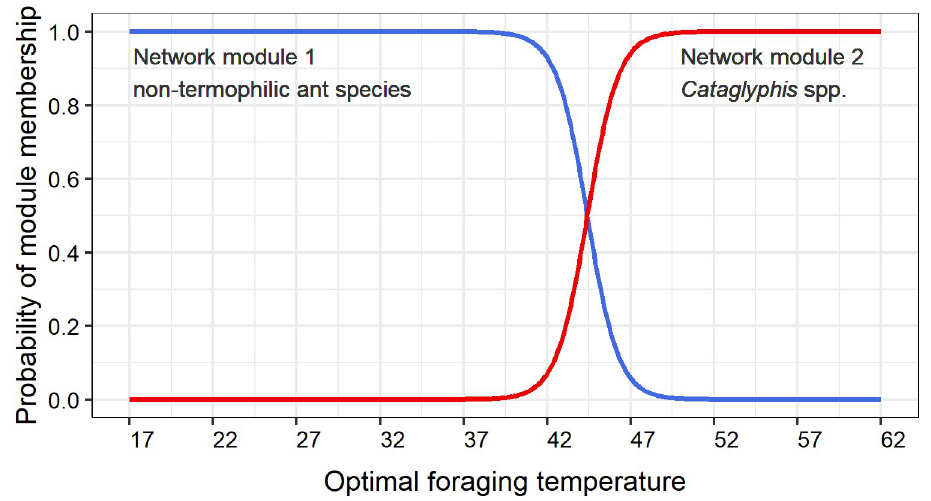
Fig 4. Probability of network module membership based on the species’ optimal foraging